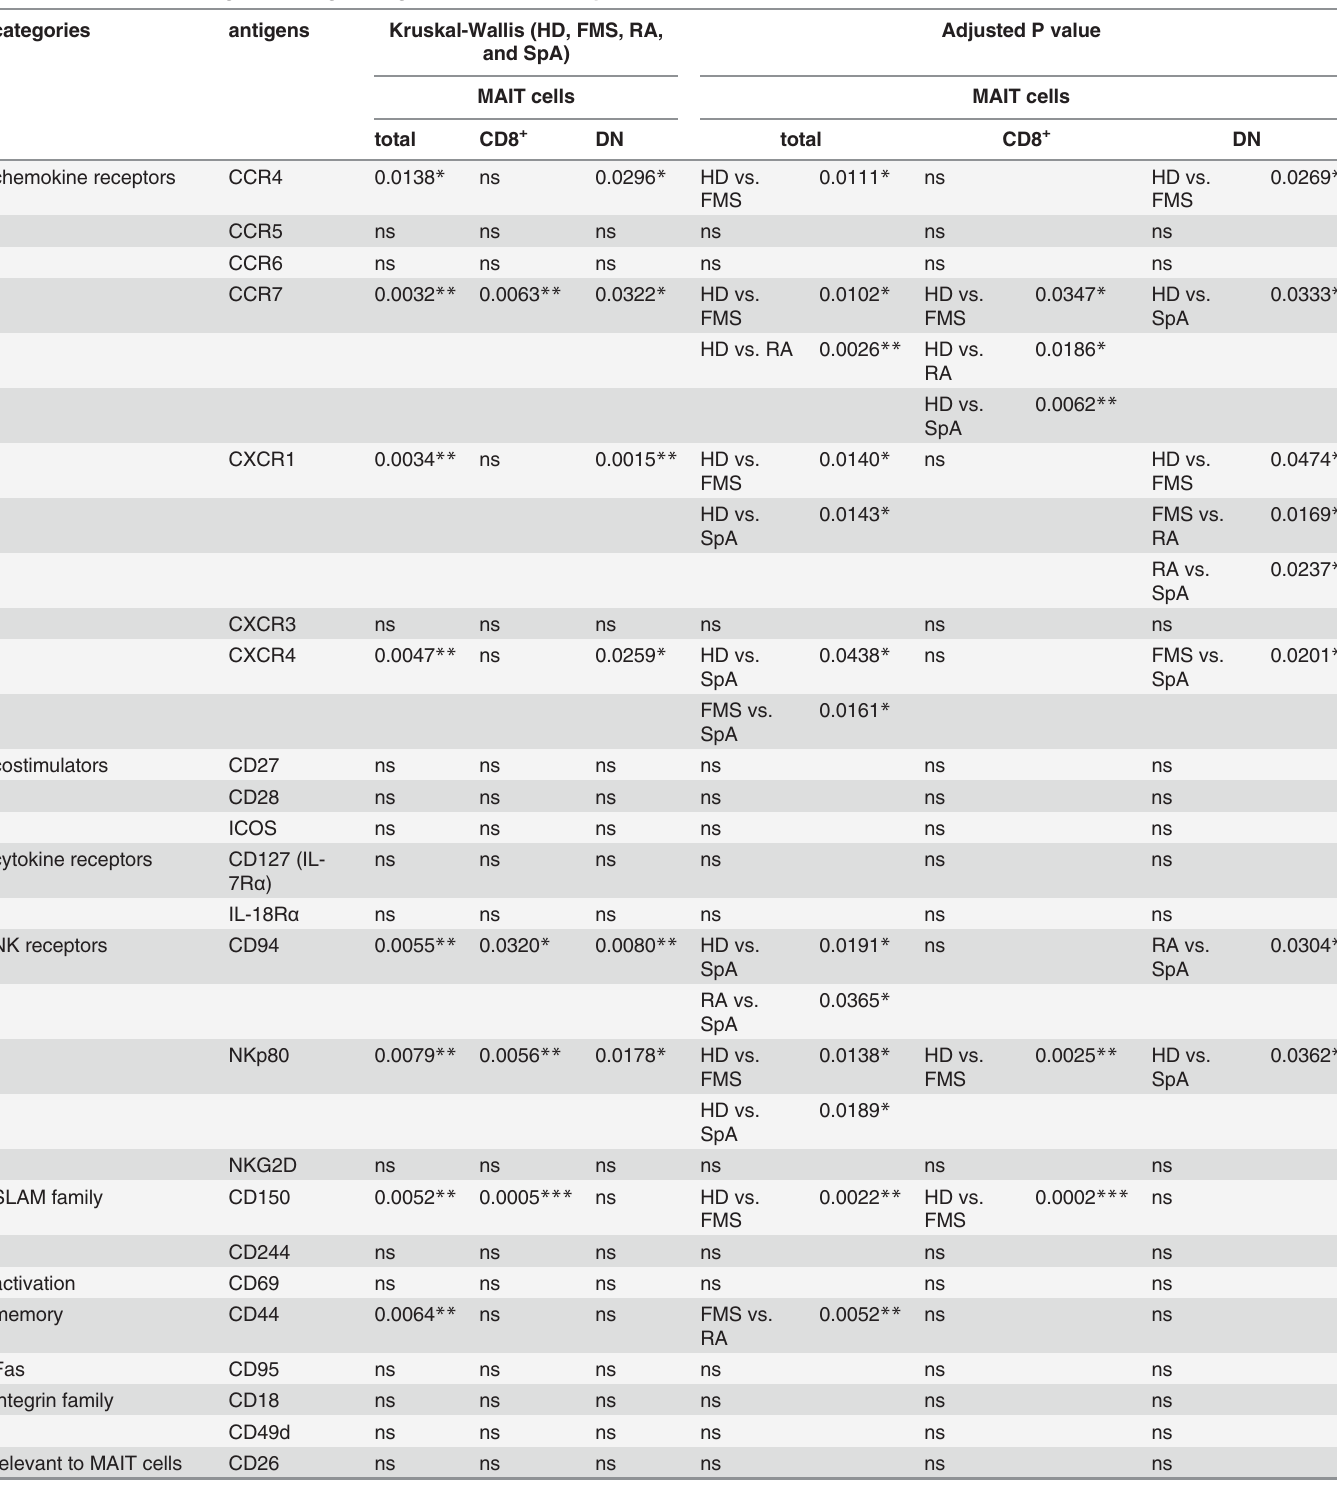
Table 3. Cell surface antigens distinguishing HD, FMS, RA, and